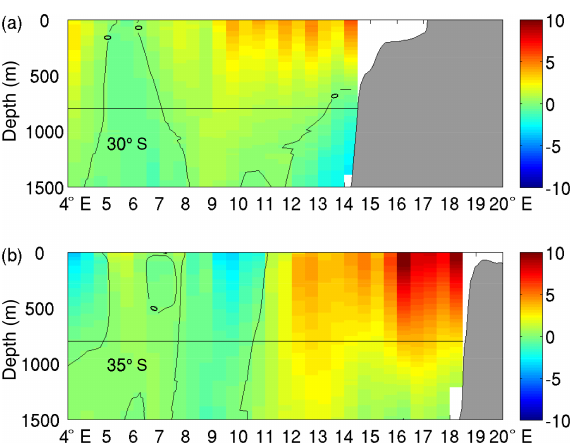
Figure 3. Climatological mean of the meridional geostrophic veloc- ity across 30 ◦ S (a) and 35 ◦ S (b) . Black lines are the contours of zero velocity and the black straight line marks the depth of 800m.